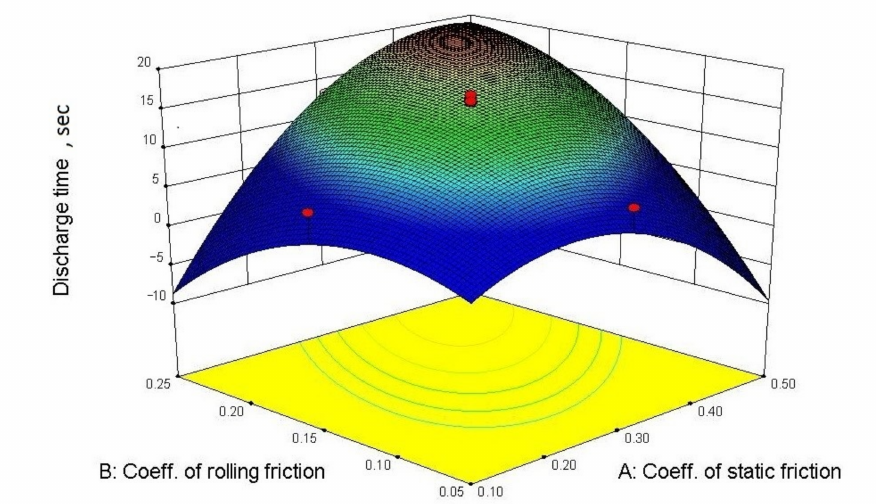
Figure 13. Response surface of the DT versus the AB